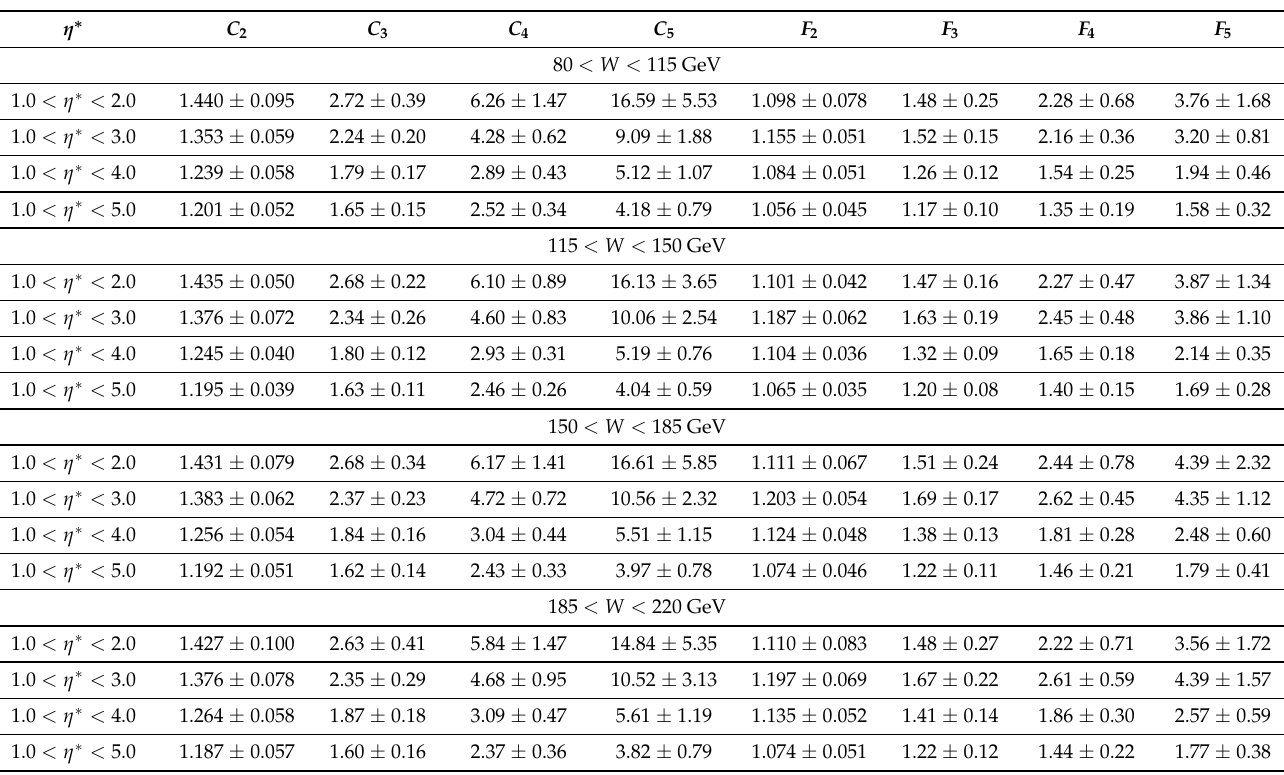
Table 5. Normalised moments and normalised factorial moments calculated from the data [33] for different W